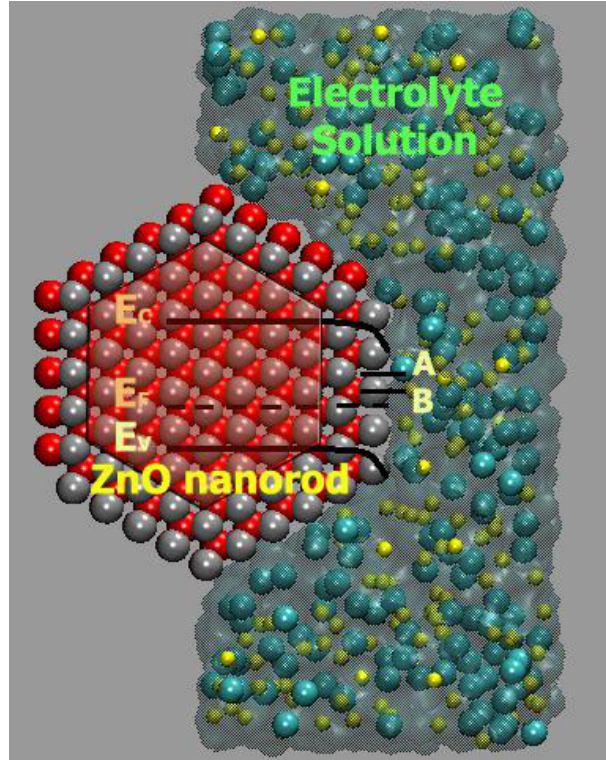
Figure 20. Schematic representation to the situation of the energy levels ZnO and surface states levels for ≡ZnC1 − and ≡ZnO − groups which are labels as A and B,